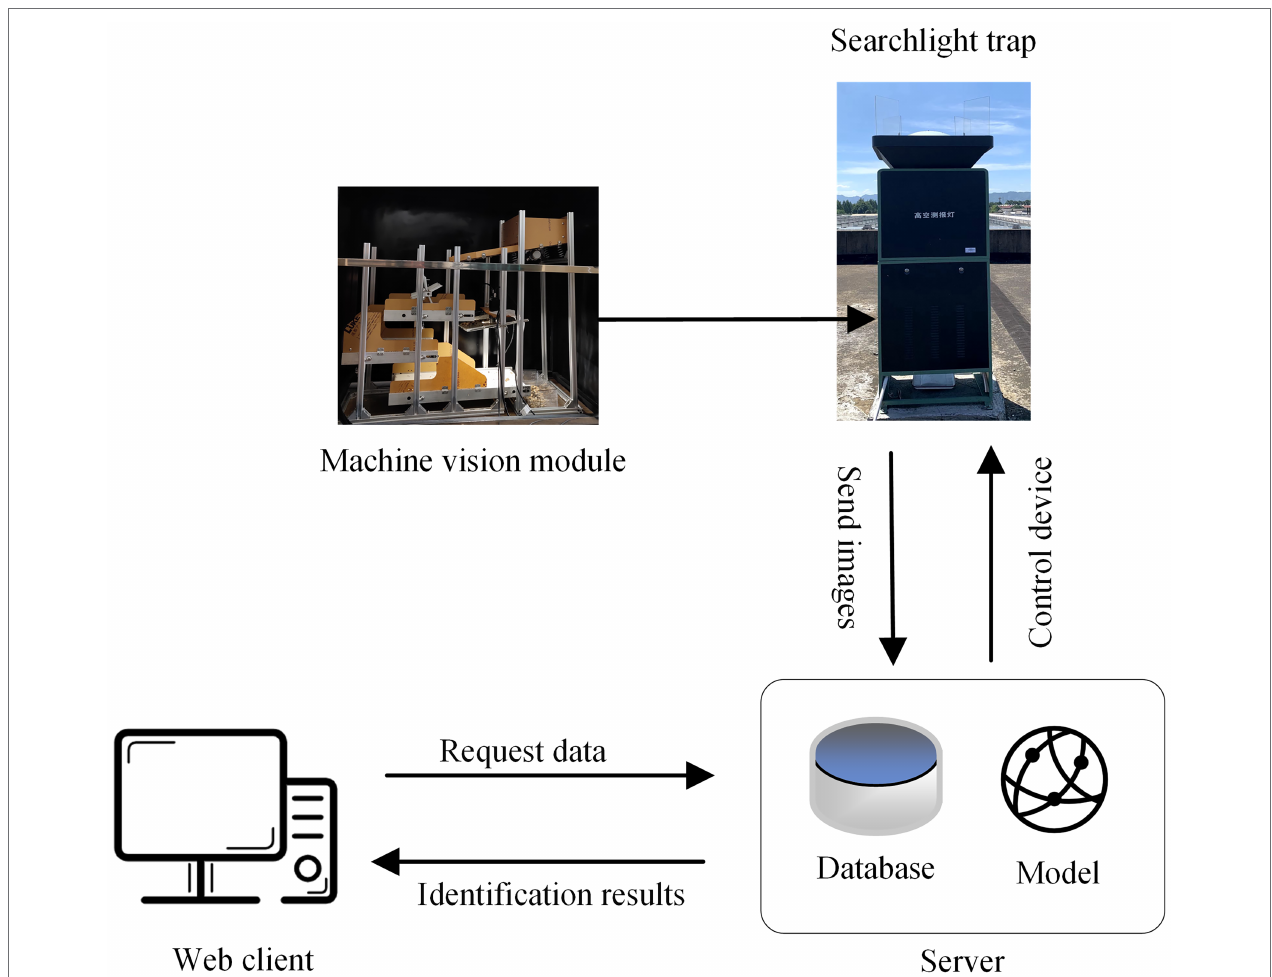
FIGURE 1 | Intelligent monitoring system of rice migratory pests based on searchlight trap and machine vision.